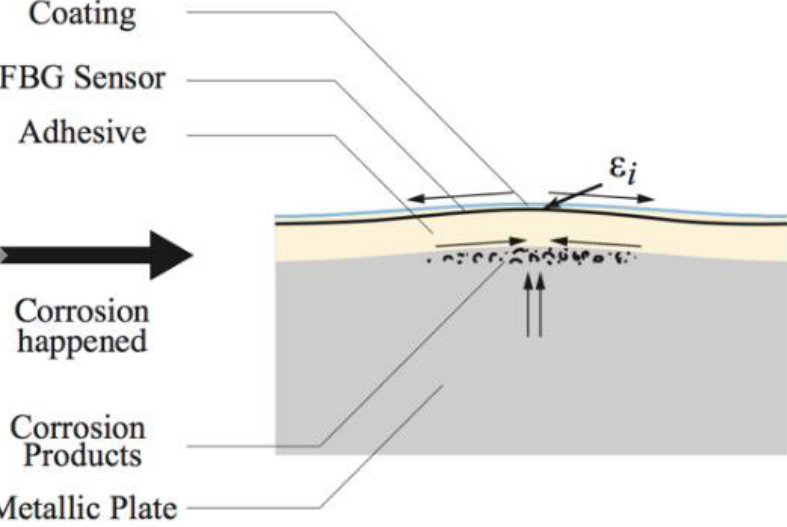
Figure 16. Detection of corrosion blister forming under a coating by a Braggs grating (Reprinted from ref. [65]).